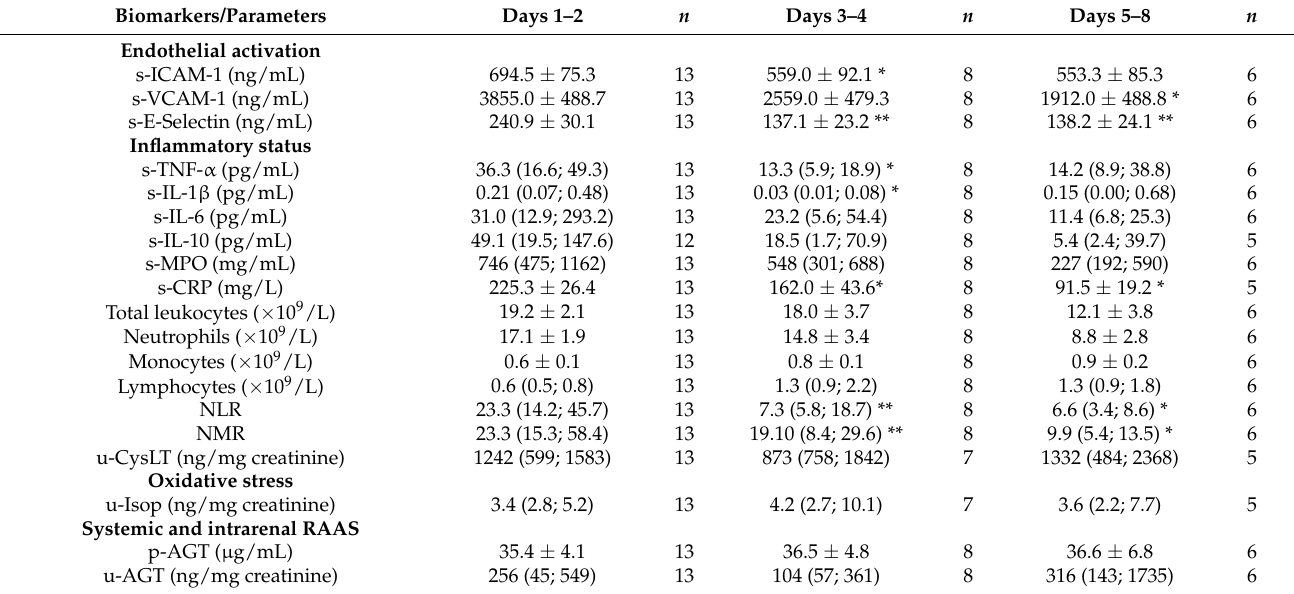
pressed as mean ± SEM or as median (25th percentile; 75th percentile) for data with normal or non- normal distribution, respectively. * p < 0.05 vs. days 1–2; ** p < 0.01 vs. days 1–2. The values of u- CysLT, u-Isop, and u-AGT were corrected for the respective urinary creatinine concentrations.